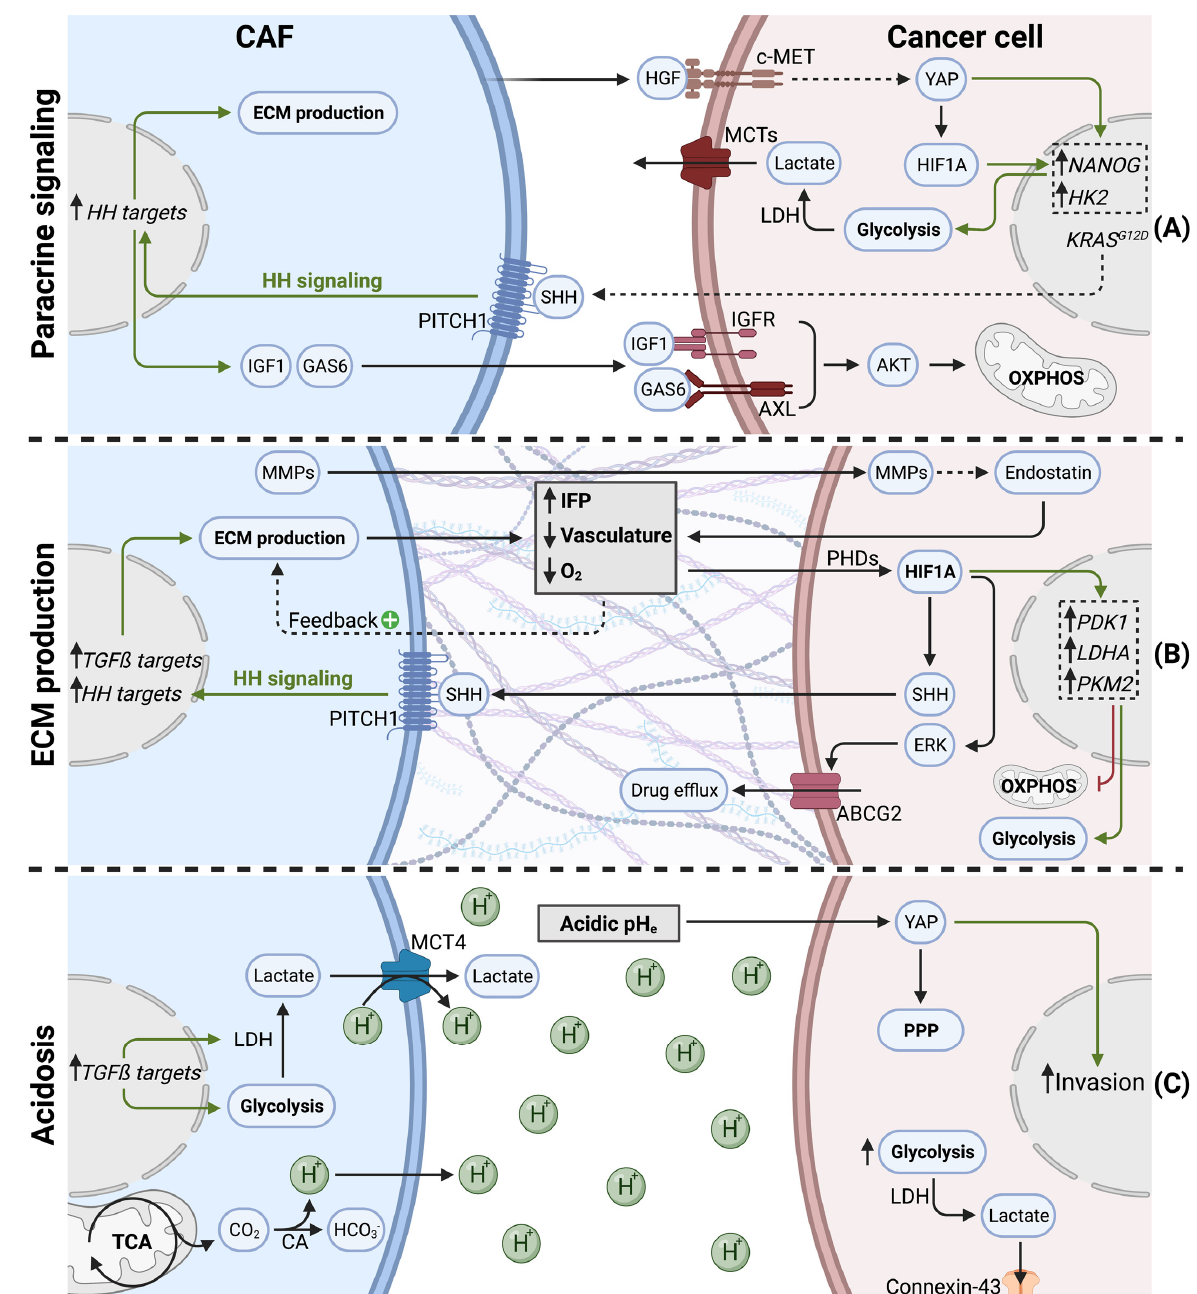
Figure 3. Indirect effects of cancer-associated fibroblasts on cancer cell metabolism in PDAC. ( A ) CAFs secrete cytokines and growth factors to orchestrate cancer cell metabolism. ( B ) CAFs produce ECM (desmoplasia), leading to hypovascularization and hypoxia. Desmoplasia and hypoxia stabilize HIF1A, shifting cancer cell metabolism towards glycolysis and promoting drug efflux. ( C ) CAFs favor acidic pH e (tumor acidosis) via increased H + secretion. Acidosis promotes cancer cell invasion, glycolysis, and metabolic waste trafficking in